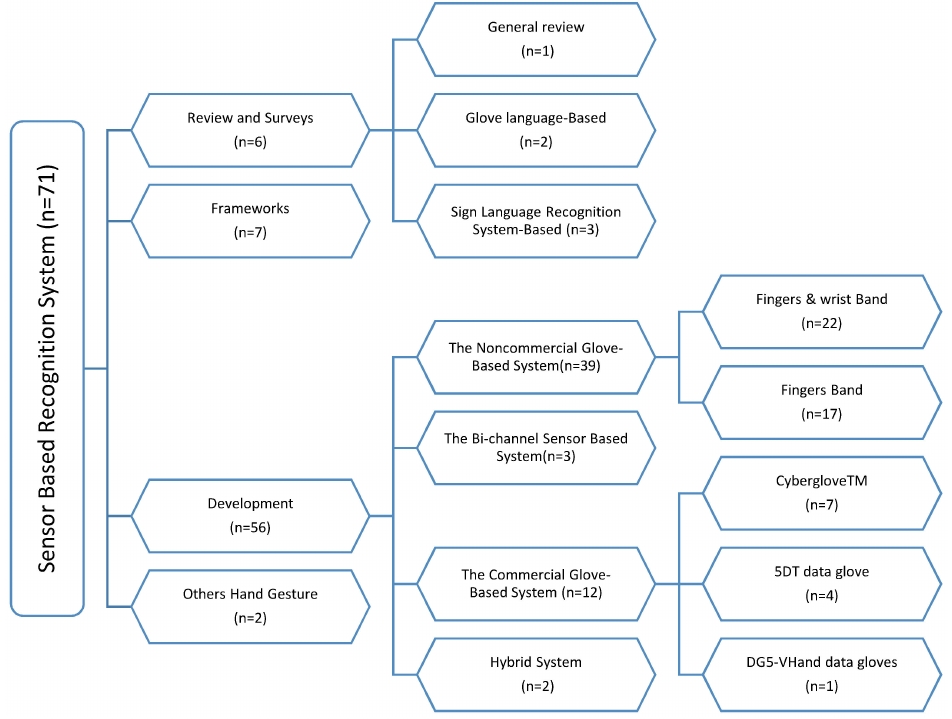
Figure 16. A taxonomy of literature concerning sensor-based sign language